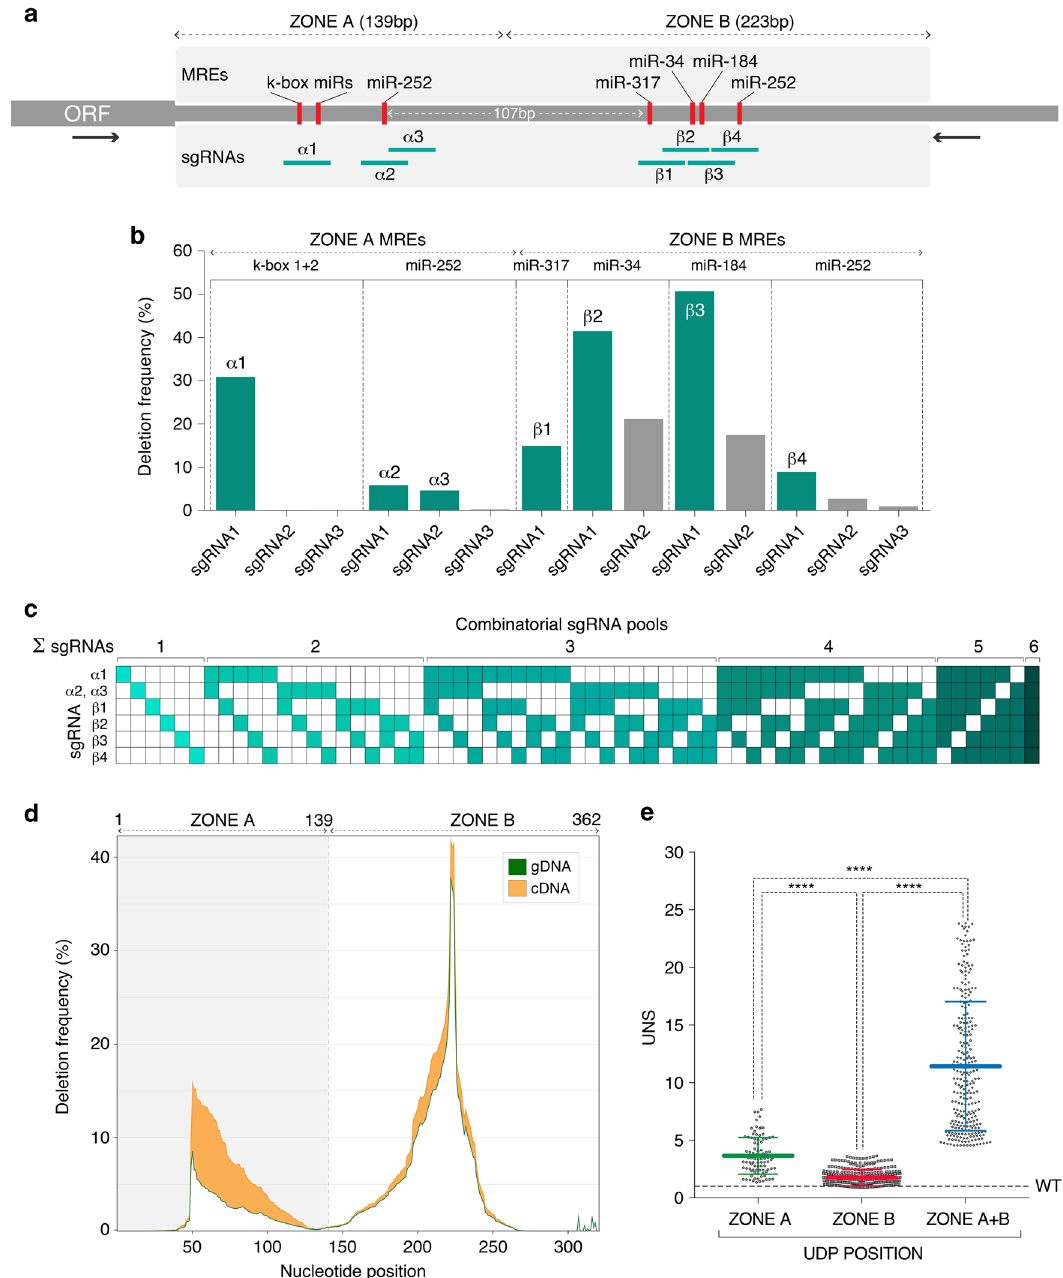
Fig. 4 Implementation of GenERA for combinatorial RRE analysis. a CG9257 3 ′ UTR displaying the boundaries of Zone A and Zone B, identity and position of all predicted MREs ( red ; low stringency miRanda target prediction algorithm), fi nal sgRNAs designed to target each MRE ( green ), and gDNA/cDNA NGS library primers ( black arrows ). b The ef fi ciency of all sgRNAs was tested by NGS and represented as percentage of reads containing deletions in the gDNA library (y axis). Final sgRNAs ( green ) were selected based on their ef fi ciency and position relative to the seven predicted MREs. Since sgRNAs α 2 and α 3 which targeted zone A miR-252 MRE had relatively low ef fi ciencies (5.8 and 4.6% respectively), they were delivered together in all combinatorial pools in order to increase the chance of generating miR-252 MRE deletions. c sgRNA multiplex strategy. All possible individual and combinatorial sgRNA pools ( n